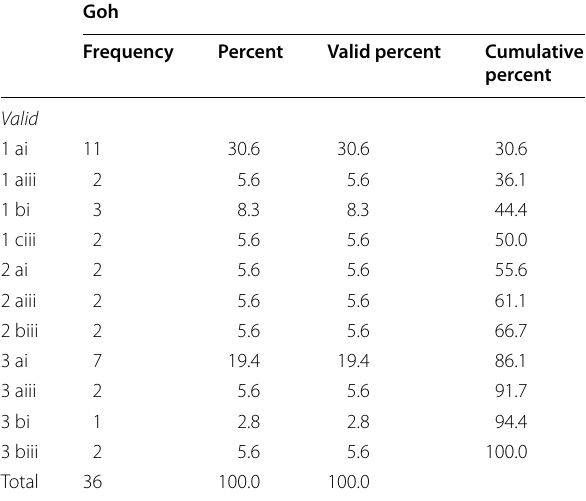
Table 1 Goh classification, 1–3 distance between distal edge of the fistula from external urethral meatus, a-c size of the fistula, i-iii complexity of the